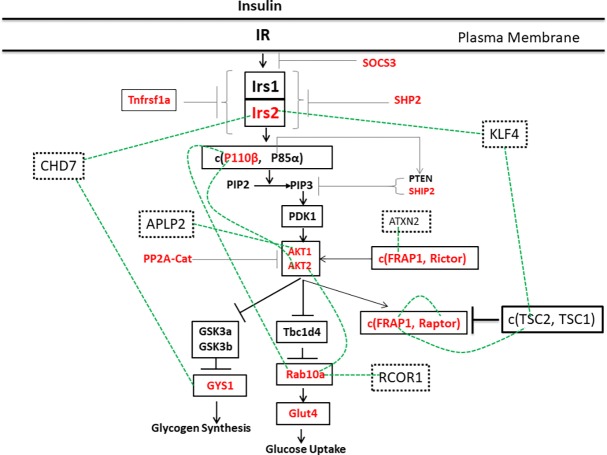
Network expansion around anchor genes in the insulin signaling pathway.A simple representation of key intermediates and modulators of the insulin signaling pathway is shown. Anchor genes in the pathway are marked in red and novel genes introduced into the network by BAKE are given in dashed boxes. Relationships between novel genes and anchor genes and between different anchor genes identified by BAKE are indicated by green broken lines. Gene associations were derived from the following BAKE clusters that were obtained using the 15 anchor genes together with the 20 closest neighbors of different anchor genes (anchor gene used given in parentheses, anchor genes forming clusters given in bold): KLF4-IRS2-TSC2, CHD7-GYS1 (IRS2); ATXN2-FRAP1, RCOR1-Rab10 (P110ß), ALPL2-AKT1 (AKT2), P110ß-AKT2-Rab10 (AKT1) and TSC2-FRAP1-Raptor (FRAP1).